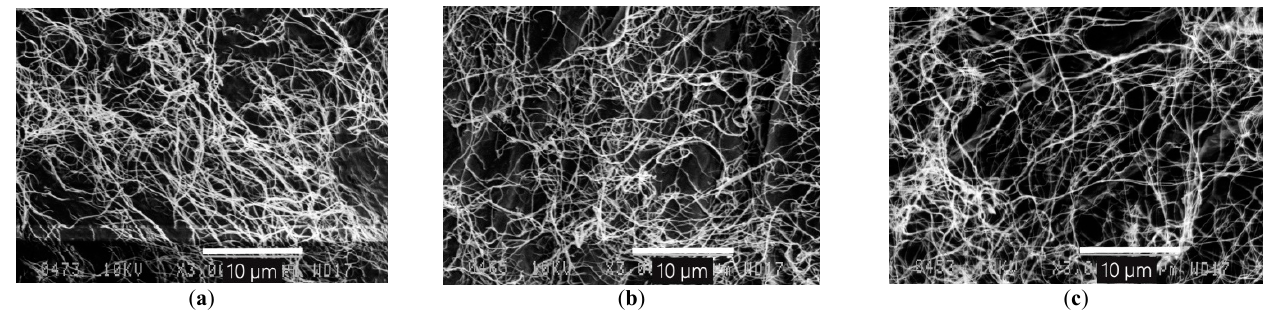
Figure 4. SEM images of BNC: ( а ) Sheet 1, ( b ) Sheet 2/1 and ( c ) Sheet 2/2 at a zoom of ×3000. Table 2 lists cellulose degrees of polymerization, strength behavior and TGA data for BNC. For the all three BNC sheets, the degree of polymerization had high values ranging